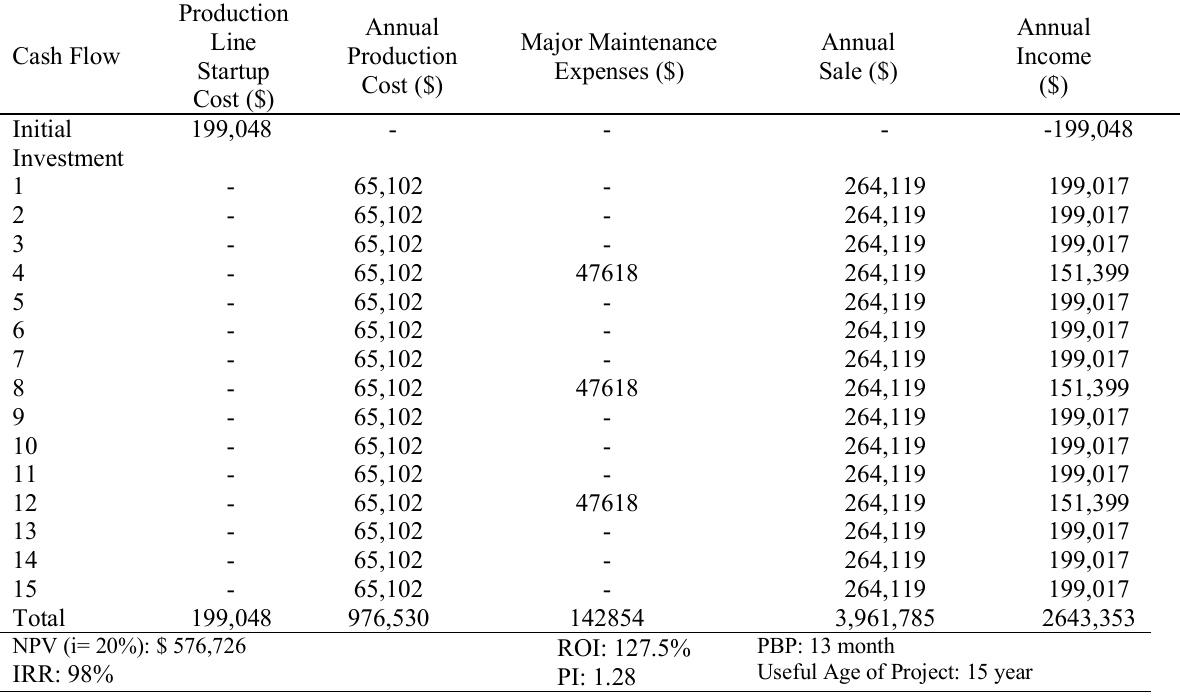
Table 5. The Financial Process of Producing and Selling RDF as a complementary fuel Cash